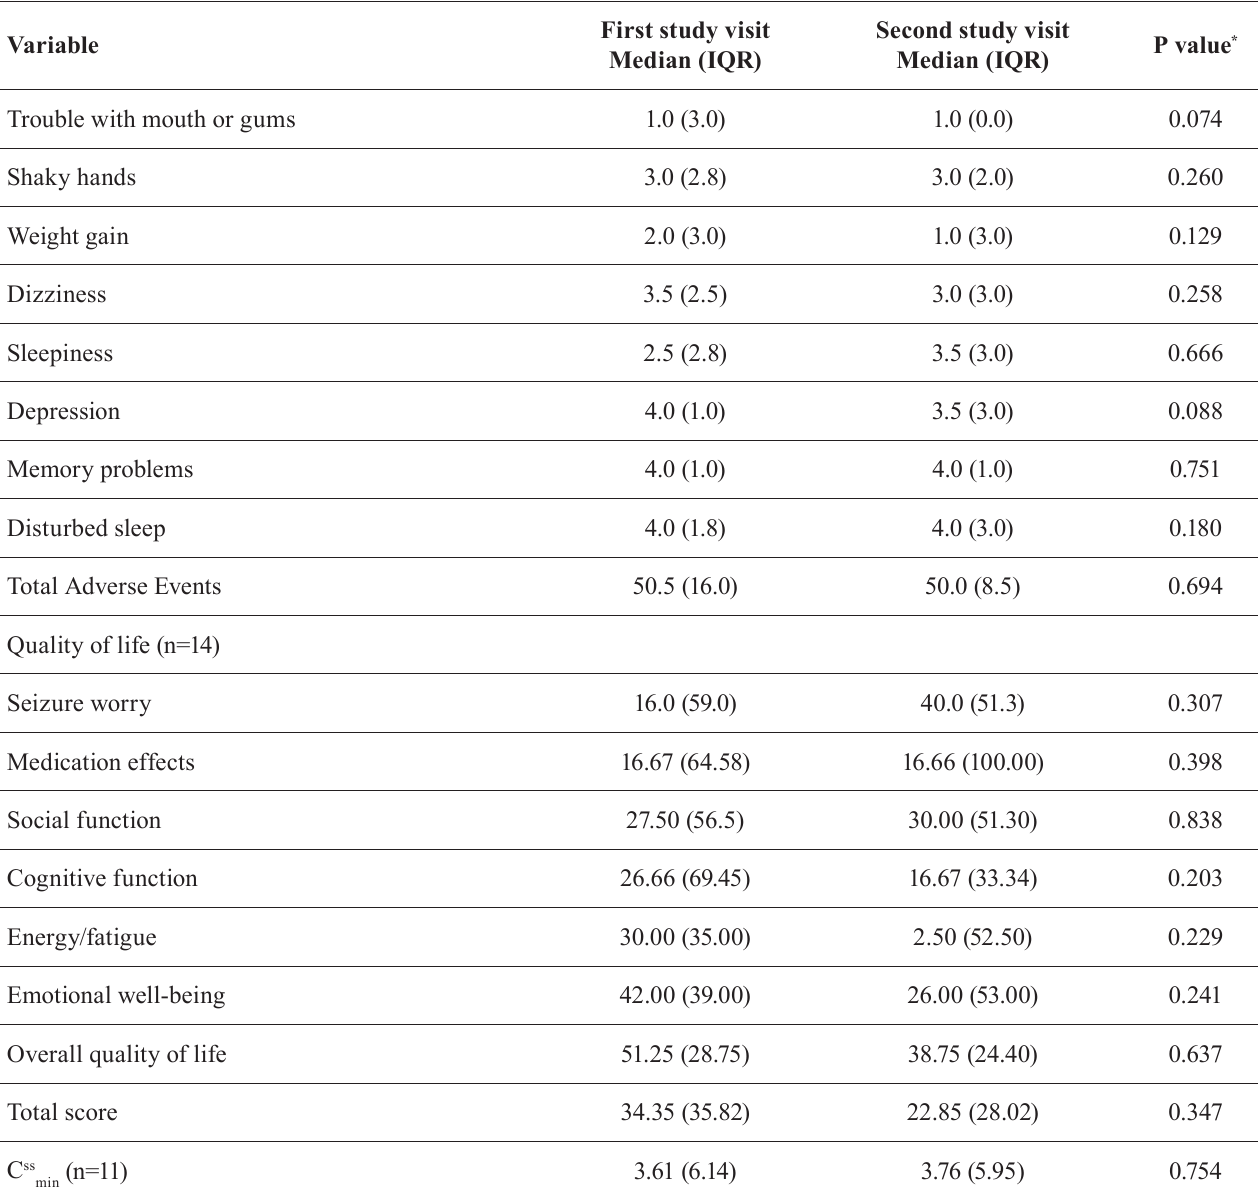
TABLE II - Adverse events profile, quality of life and carbamazepine plasma concentrations before and after the brand/ manufacturer